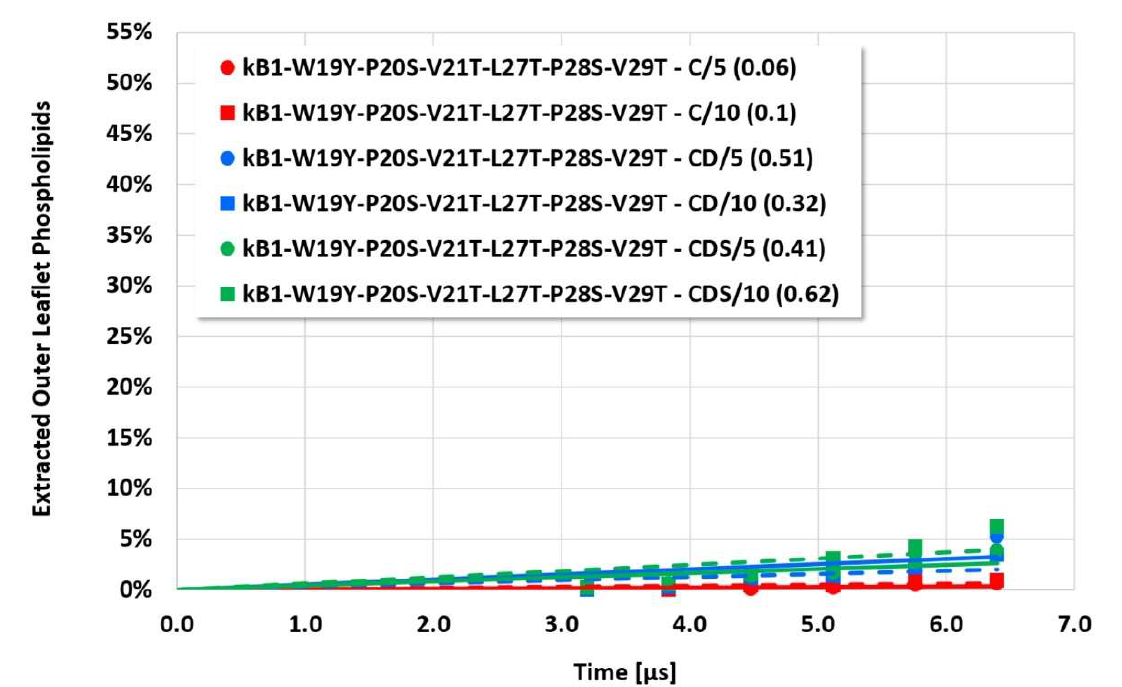
Figure 4. Cyclotide/membrane system kB1-W19Y-P20S-V21T-L27T-P28S-V29T/NoC-PM: Quanti- tative evaluation of the cyclotide-induced extraction of membrane lipids into the cyclotide/water compartment for the different approaches (C, CD, CDS) and different electrostatic cut-off radii (5 or 10 reduced DPD length units). The resulting rates of membrane disruption (percent of outer leaflet phospholipids being extracted per microsecond) are provided in brackets.